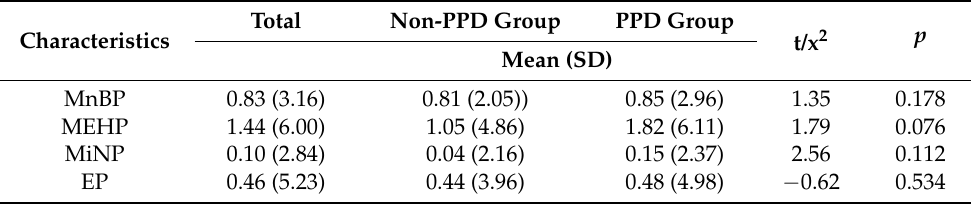
Table 3. Mean concentrations of MnBP, MEHP, MiNP, and EP according to postpartum groups.